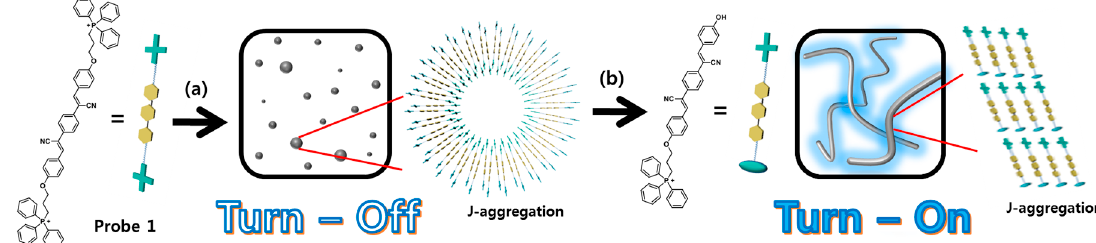
Figure 1. Chemical structures of probes 1 and 2 .